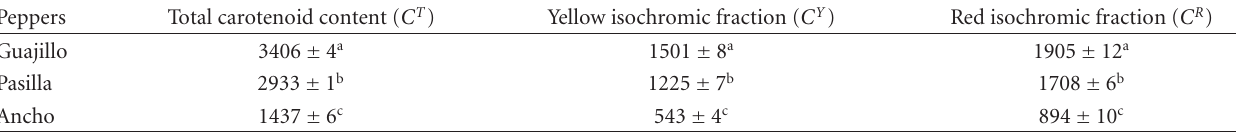
Table 1: Isochromic fractions (yellow and red) and total carotenoid contents of extracts from dried peppers ( μ g/g). Peppers Total carotenoid content ( C T ) Yellow isochromic fraction ( C Y ) Guajillo